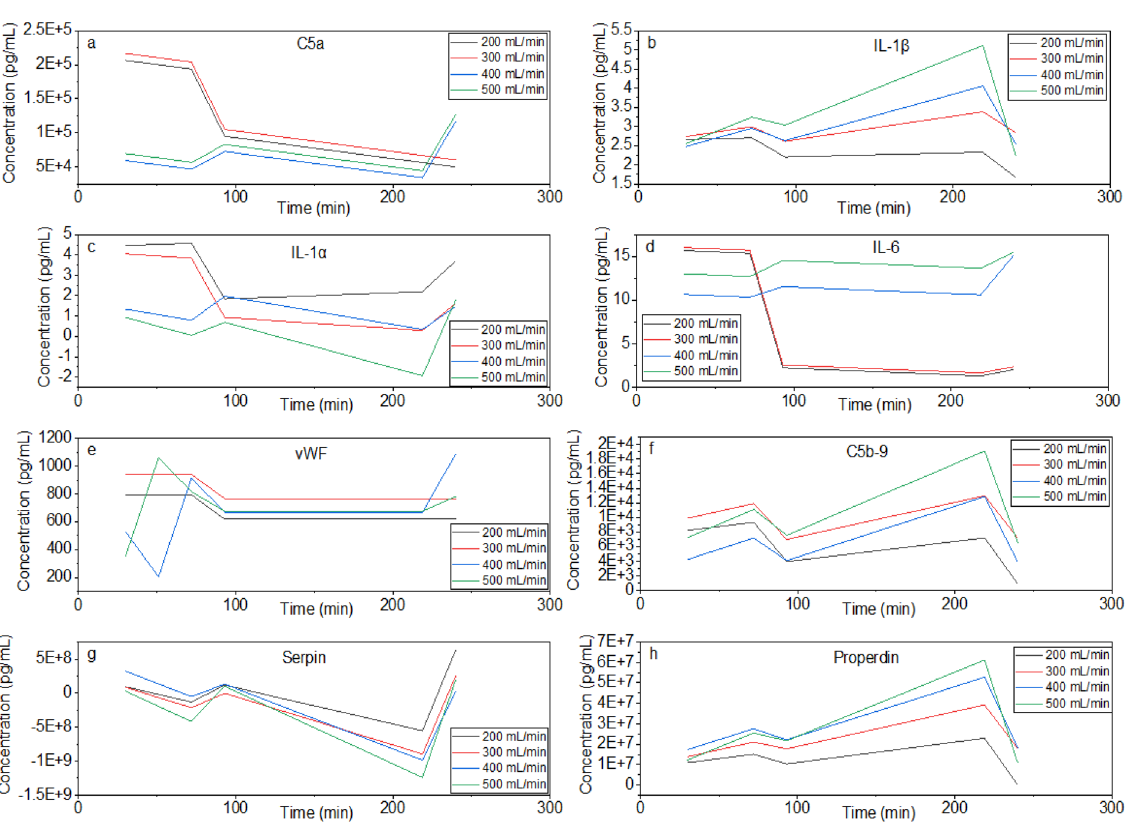
Figure 2. Prediction of biomarker concentrations using the extended model (Origin(Pro), Version 2020b, https:// www. origi nlab. com/ index. aspx? go= Produ cts/